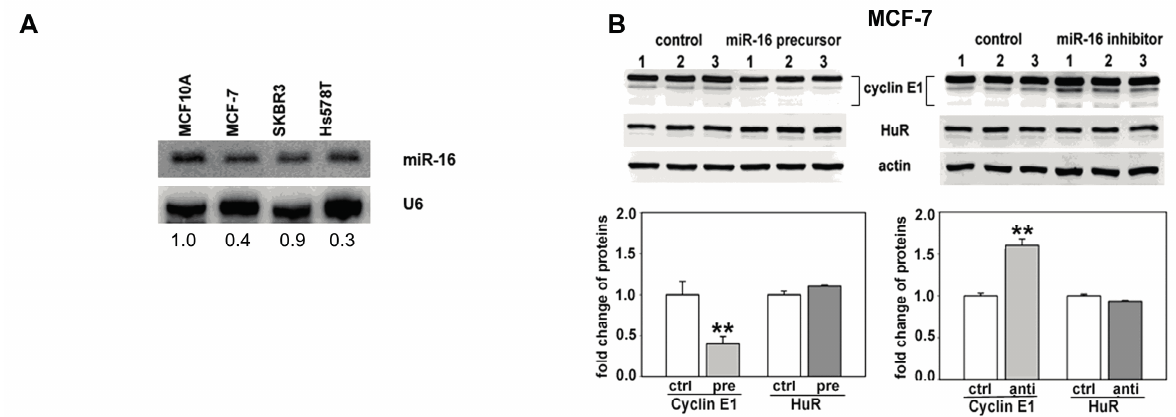
Figure 1. HuR binds U-rich regions of the cyclin E1 3'UTR. ( A ) MCF7 cells were transfected with pcDNA3.1 (vec) or pcDNA3.1 myc-HuR (HuR) or ( B ), with control siRNA (si-ctrl) or HuR siRNA (si-HuR). 48–72 h after transfection, protein was extracted for western blotting for Cyclin E1 or HuR (top). Values in the graphs are the mean fold change ± SD from three independent experiments. ** p < 0.01 versus control; ( C ) Sequence of cyclin E1 3'UTR with two HuR binding sites (underlined with light grey) and two miR-16 target sites (underlined with dark grey), as well as a schematic depiction of the cyclin E1 mRNA including the 5'UTR, coding region (CR) and 3'UTR. FL (full length cyclin E1 3'UTR) and ( A – E ) are 3'UTR segments used for UV cross-link and UV cross-link competition experiments shown in panels D and E; ( D ) The binding of GST-HuR with the cyclin E1 3'UTR detected by UV cross-link analysis; and ( E ) Specific or non-specific binding of GST-HuR with the cyclin E1 3'UTR measured by UV cross-link competition using E1CR378 (bases 184–378 in the coding region) as non-specific competitor. Representative crosslinks of at least three replicates are shown in panels D and